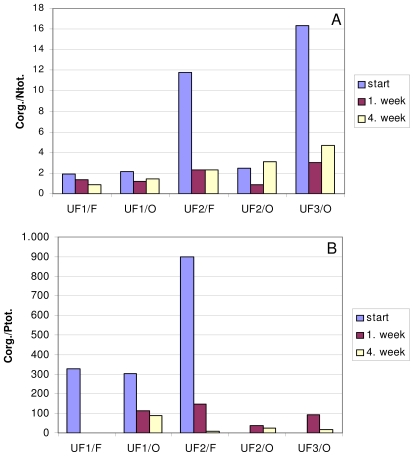
Corg./Ntot. (A) and Corg./Ptot. (B) molar ratios ultrafiltrate retentates (UF/0) and permeates (UF/F) using a nominal molecular weight cutoff of 30–10 (UF1), 10–5 (UF2) and <5 kDa (UF3) at the start, after 1 week and after 4 weeks of the degradation experiment.